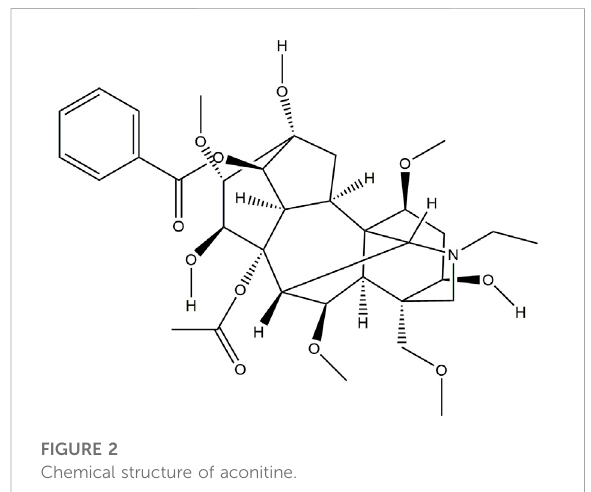
FIGURE 2 Chemical structure of